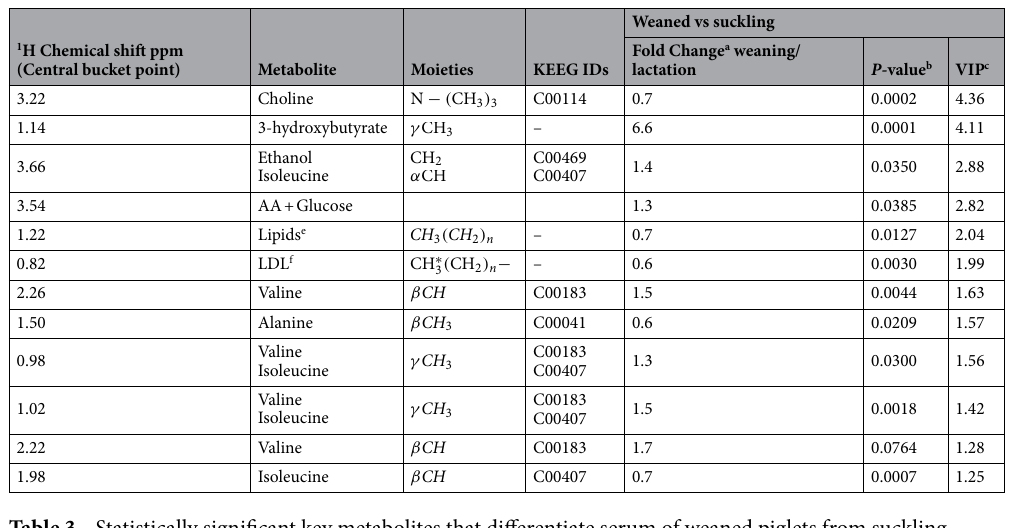
Table 3. Statistically significant key metabolites that differentiate serum of weaned piglets from suckling piglets. a Fold change was calculated by dividing the mean of normalized integral of each plasma metabolite in the former by the mean of normalized integral of each plasma in the latter. Fold change > 1 indicates that the metabolite was incremented, whereas fold change < 1 indicates the metabolite was reduced. b P -values were derived from Student’s t -test. c VIP value was derived from OPLS-DA with a threshold of 1.0 d TMAO: Trimethylamine-N-oxide. e Lipids: Triglycerides and fatty acids. f LDL: Low density